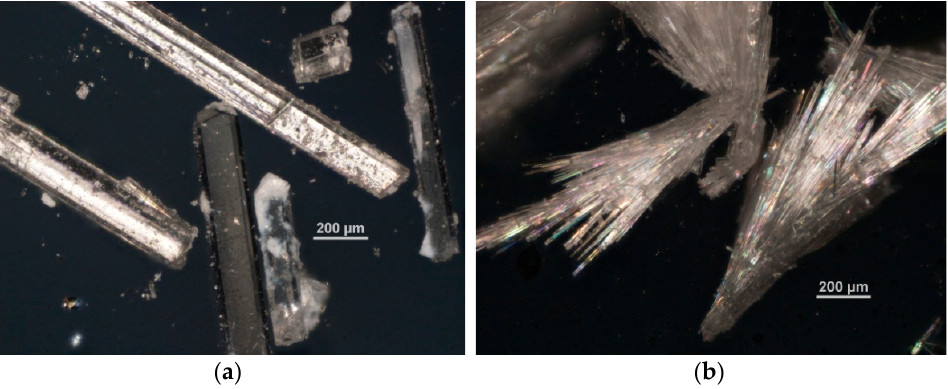
Figure 3. Images of the habit of crystals: ( a ) ( − )- 2 •( R , R )-TADDOL and ( b ) (+)- 2 •( R , R )-TADDOL under polarized light microscopy.